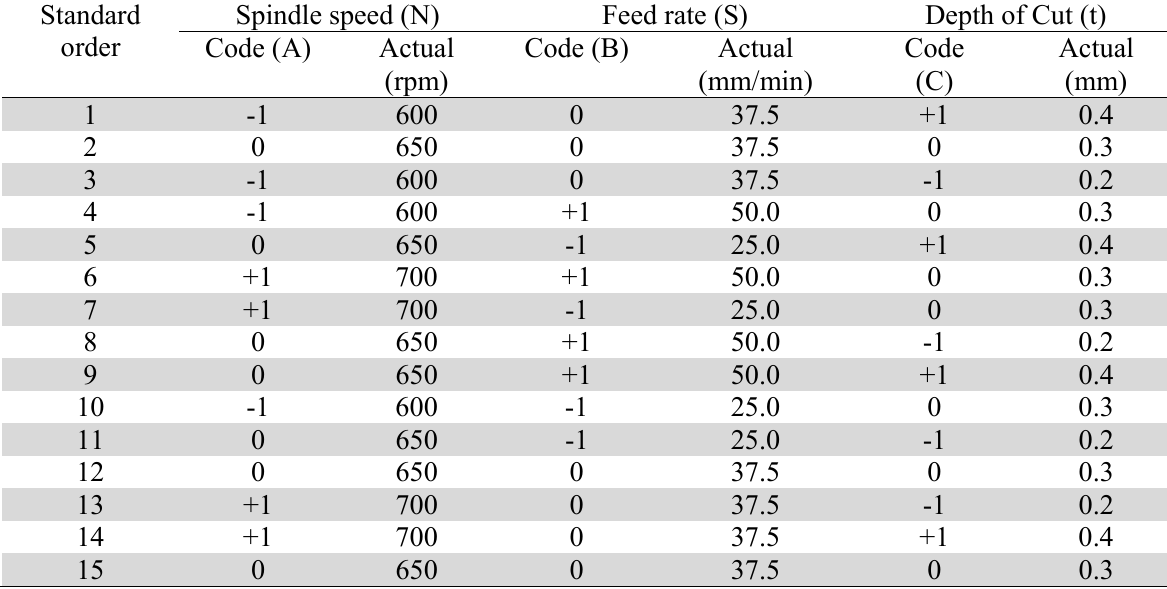
Experimental design matrix Standard